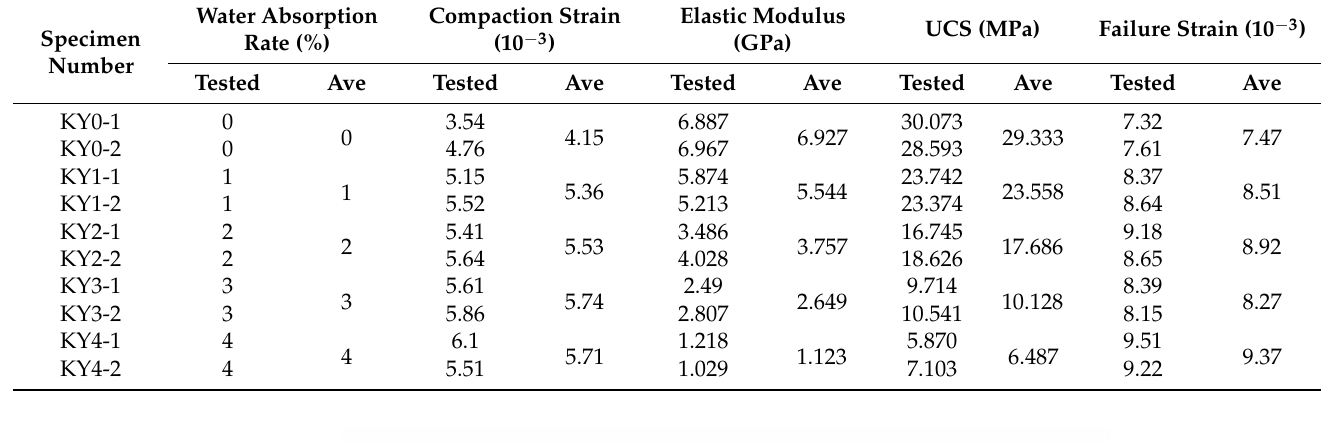
Table 3. Results of uniaxial compression test for specimens with different moisture absorption rates.